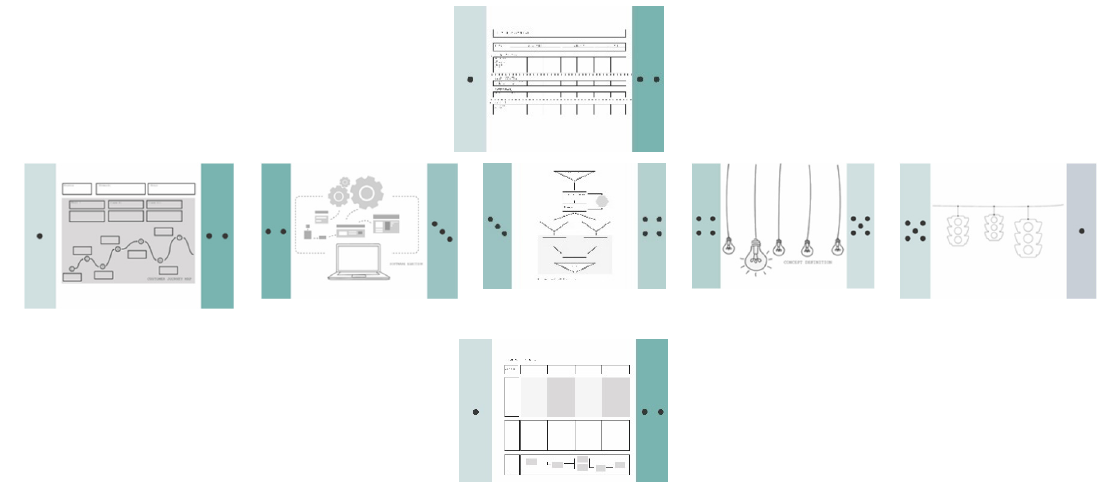
Figure 11. Example of Service Development Domino Cards.